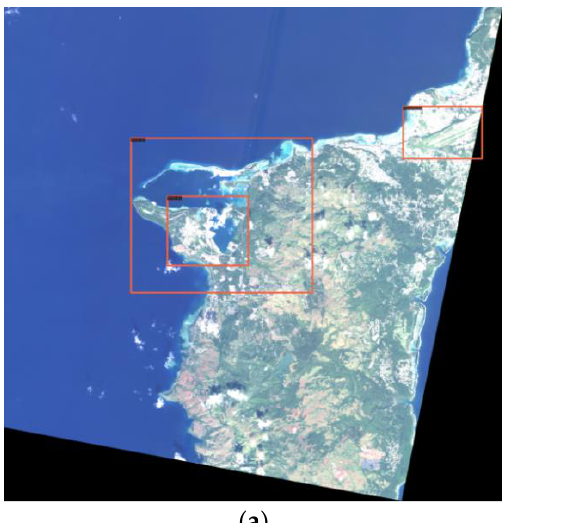
Figure 9. Port forecast comparison: ( a ) Swin-HSTPS port forecast result (confidence 0.82); ( b ) Swin Transformer port forecast results (confidence 0.78).